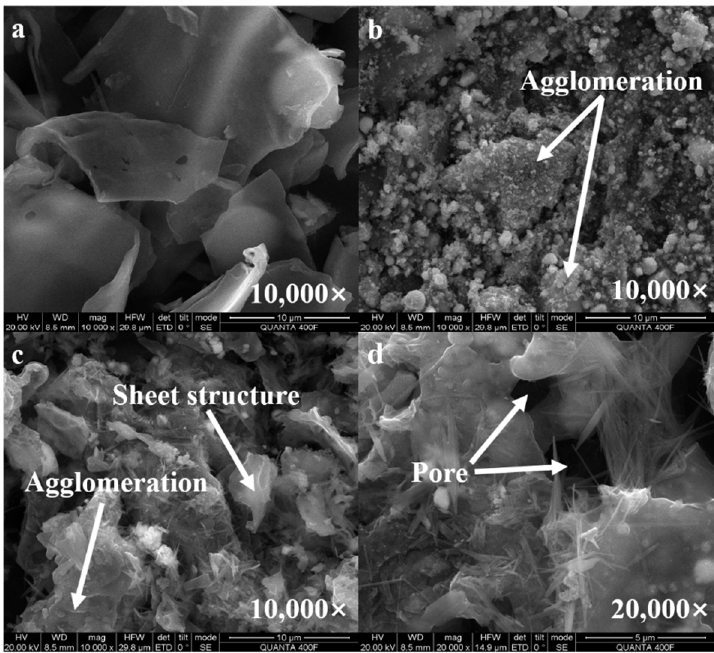
Figure 1. ( a ) SEM images of uncoupled biochar (BC), ( b ) bismuth ferrite (BiFeO 3 ), and ( c , d ) bismuth ferrite coupled with biochar material (BiFeO 3 /BC).